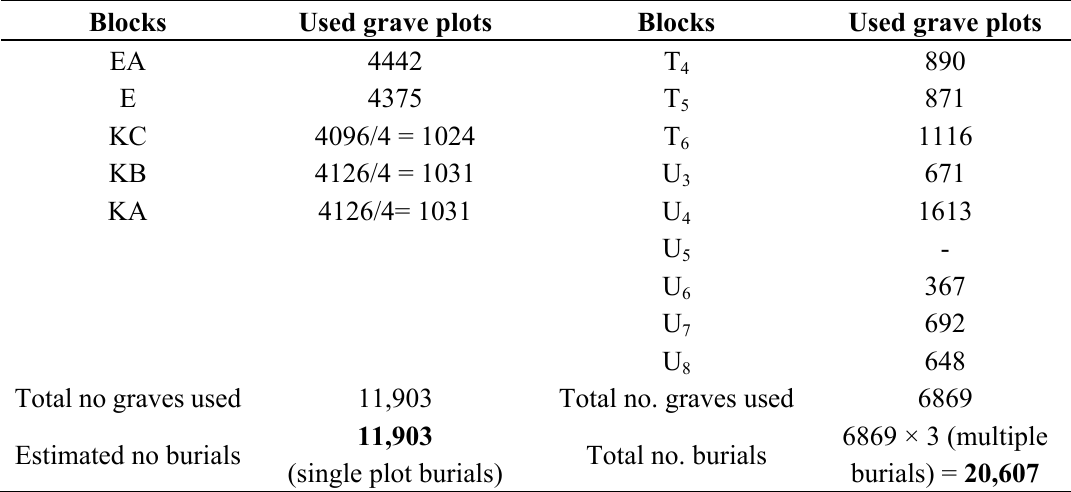
Table 2. Estimated number of burials in various blocks of Zandfontein Cemetery (2010). Blocks